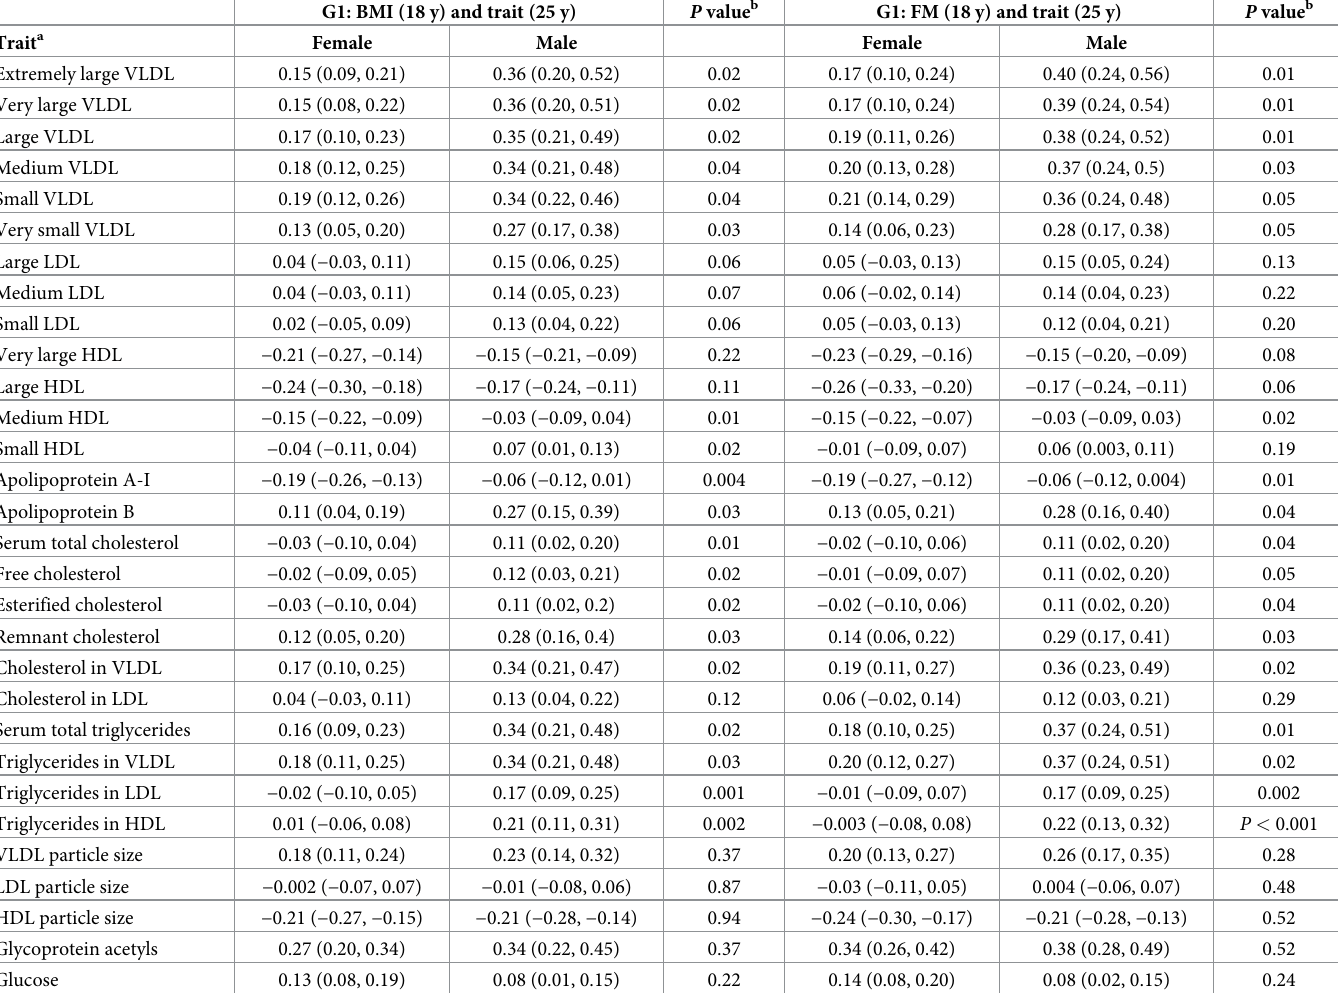
Table 4. Adjusted sex-specific associations of adiposity measures (per SD increase) at 18 y with standardised lipoprotein, cholesterol, triglyceride, and other trait concentrations at 25